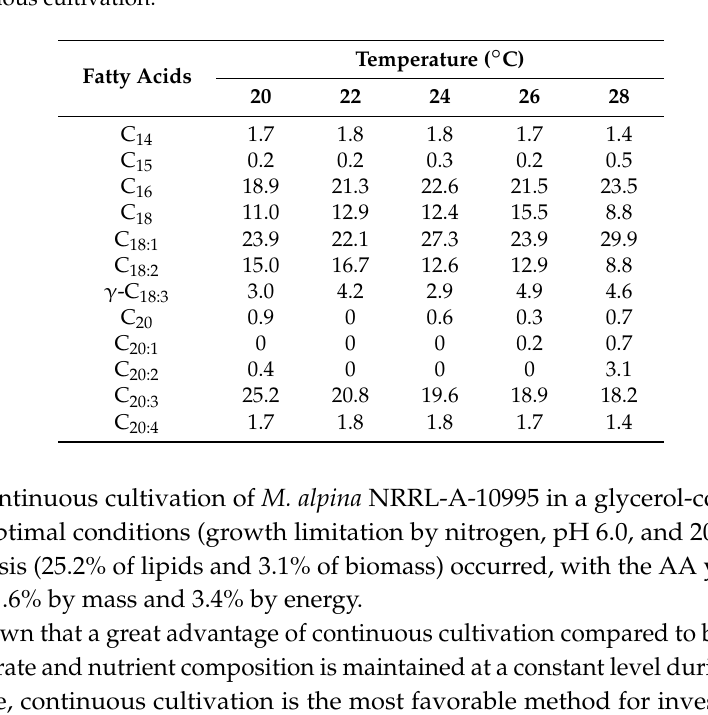
Table 6. The effect of temperature on the fatty acid composition (% of lipids) of M. alpina NRRL-A-10995 under continuous